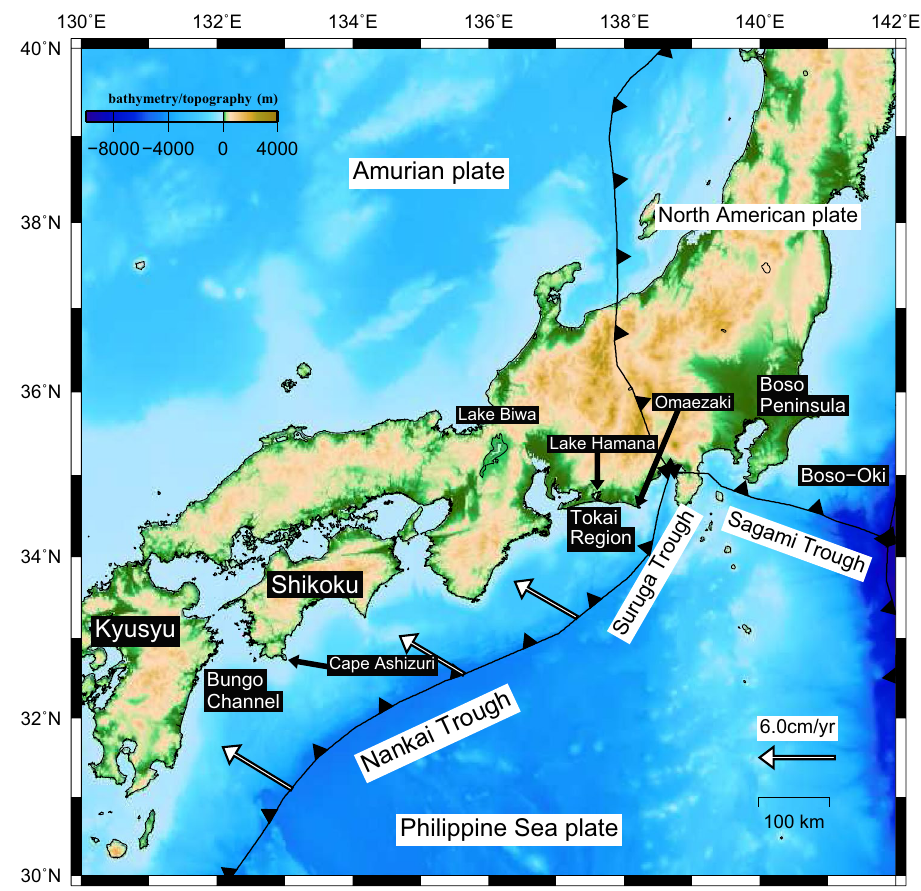
Figure 1. Tectonic map of the study area. The black barbed lines represent the plate boundary, and the triangles indicate the direction of motion of the subducting plate with respect to the plate being subducted (Bird 28 ). The white arrows represent the velocity vectors of the Philippine Sea plate with respect to the Amurian plate (DeMets et al. 22 ). The map was created by using the Generic Mapping Tools (GMT) 27 (version: GMT4.5.7, URL link: https:// www. gener ic- mappi ng- tools. org/ downl